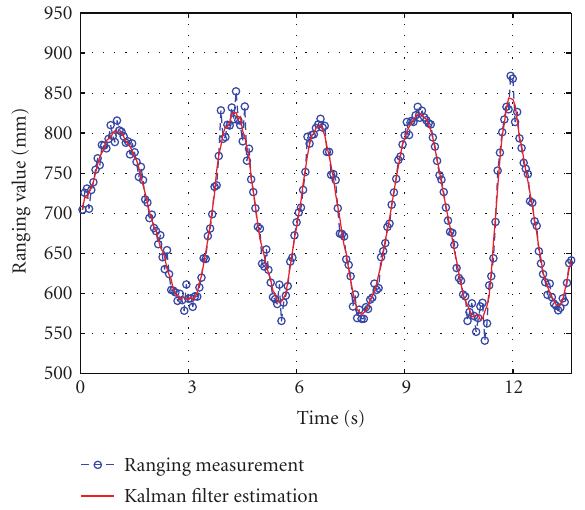
Figure 12: Evaluation of the ranging algorithms with the clutter map removal.